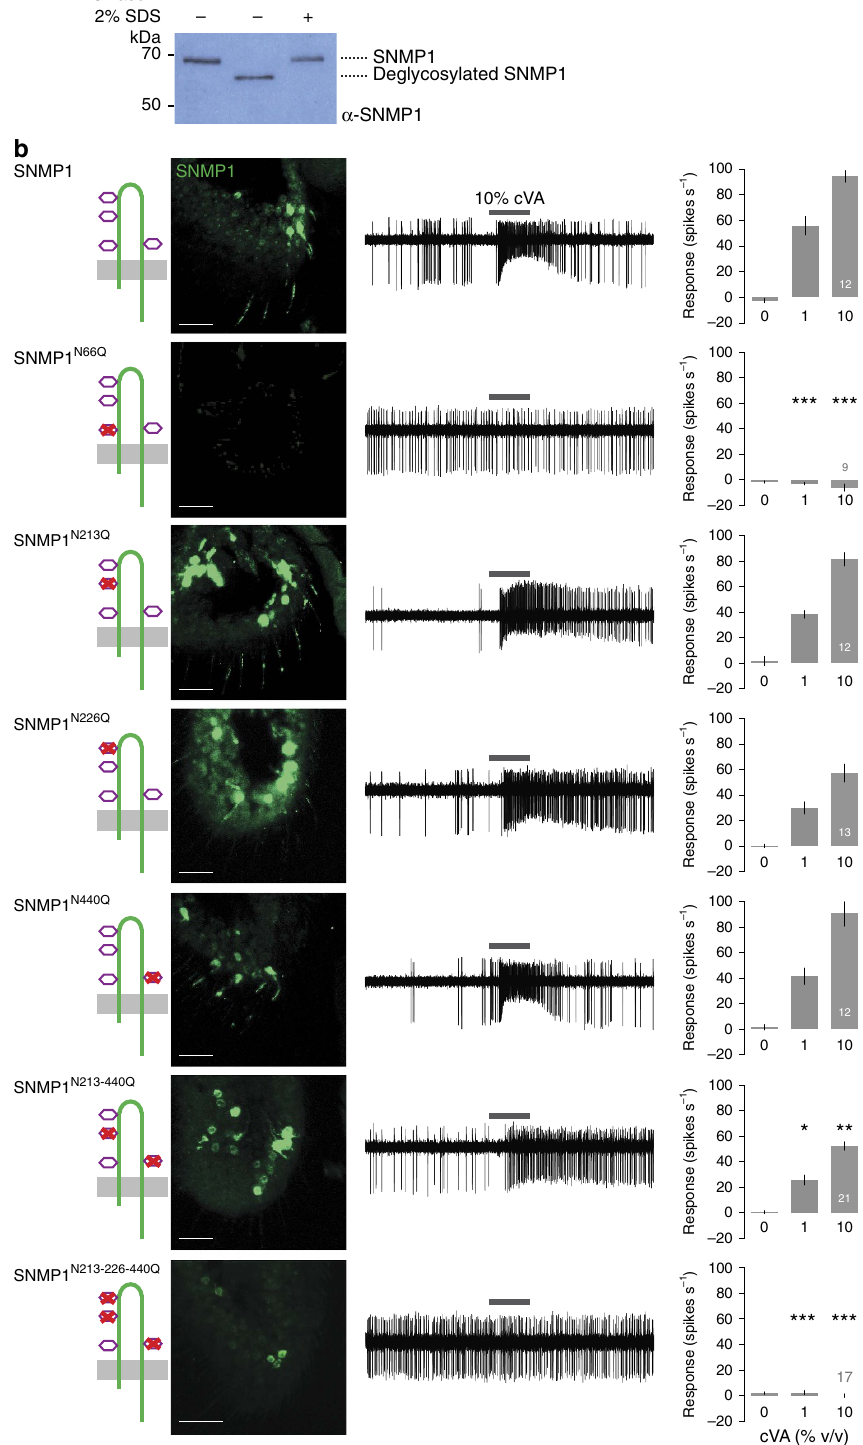
Figure 5 | Role of N-glycosylation in SNMP1 trafficking and function. ( a ) Analysis of the N-glycosylation status of SNMP1 by electrophoretic mobility assay. Total antennal protein extracts were incubated with ( þ ) or without ( (cid:2) ) PNGase F, in the presence or absence of 2% SDS (to deactivate PNGase F) and then resolved by 10% SDS–PAGE. After western blotting, immunodetection was performed with a -SNMP1. ( b ) Analysis of the rescue properties of SNMP1 mutants lacking one or more putative N-glycosylation sites as indicated in the cartoons. Left: immunostaining with a -SNMP1 on antennal cryosections. Scale bars, 20 m m. Centre: representative traces of electrophysiological recordings of OR67d neurons in male flies stimulated with 10% cVA. Right: mean neuronal responses ± s.e.m. in each genotype. There are significant statistical differences in neuronal responses due to genotype for both 1 and 10% cVA (Kruskal–Wallis, P o 0.0001). Significant differences in cVA responses of the different genotypes compared with full-length SNMP1 rescue are indicated in the figure; * P o 0.05, ** P o 0.01, *** P o